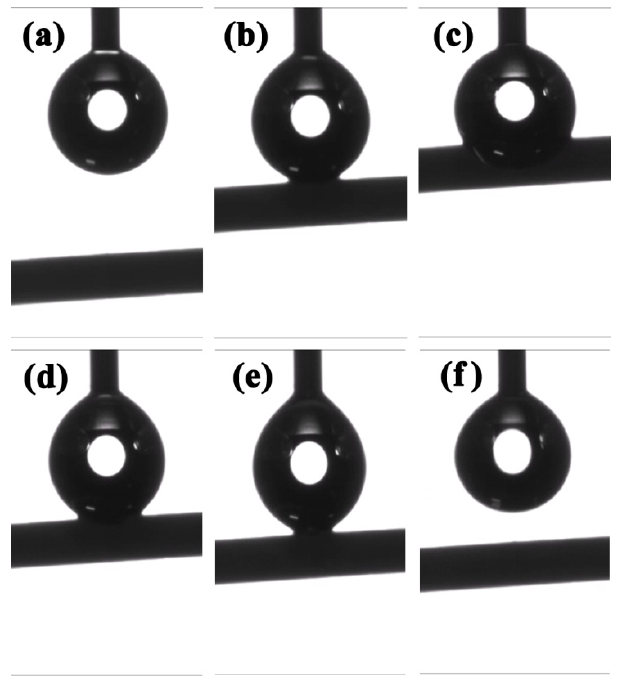
Figure 2. Wettability of CAF-3. ( a – c ) The gradual contact process between water droplets and the CAF. ( d – f ) The process of water droplets leaving the CAF.